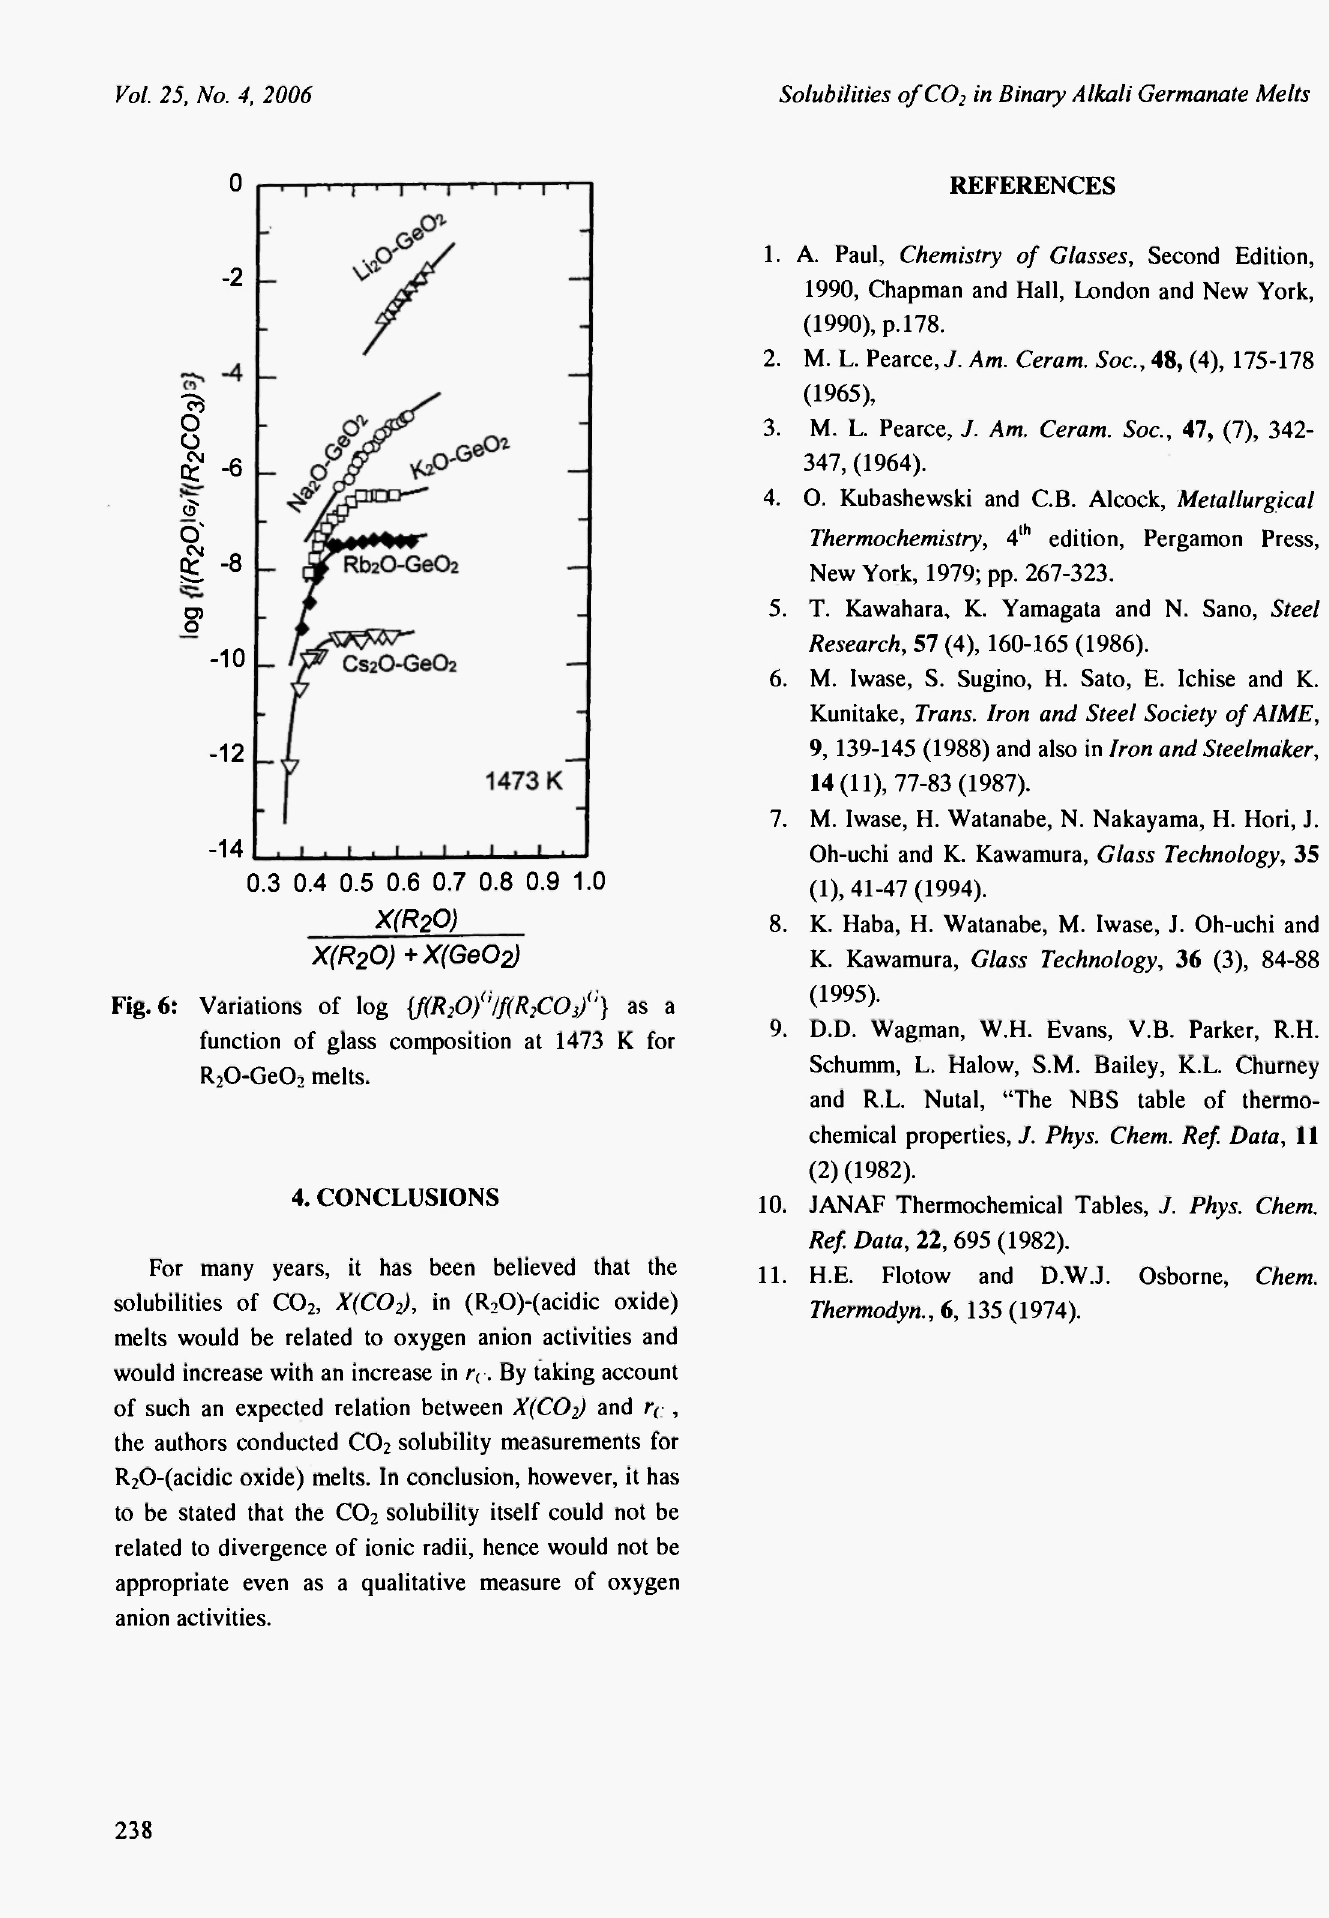
Fig. 6: Variations of log {f(R20) a /f(R 2 C0 3 / : } as a function of glass composition at 1473 Κ for R 2 0-Ge0 2